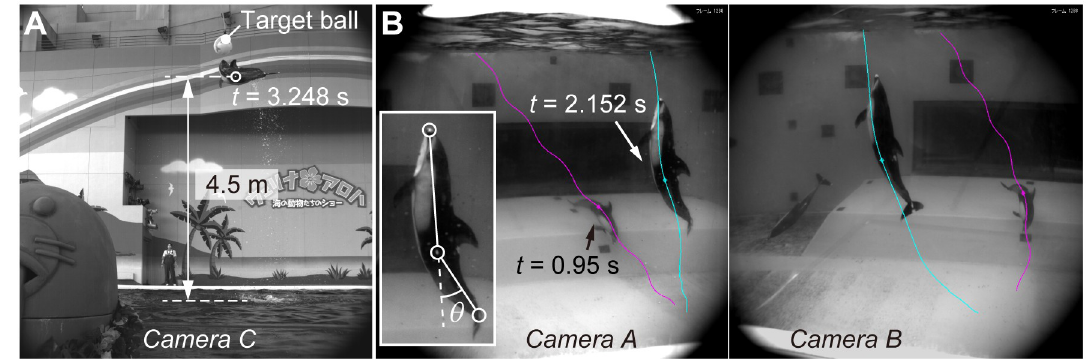
Fig 2. Example images captured by the high-speed cameras. (A) Captured image by Camera C showing the estimated height of the left lateral marker at t = 3.248 s. (B) Overlaid images captured by Camera A and B at t = 0.95 s and 2.152 s. The trajectories of the right and left lateral markers are illustrated in magenta and cyan, respectively. See also S1 and S2